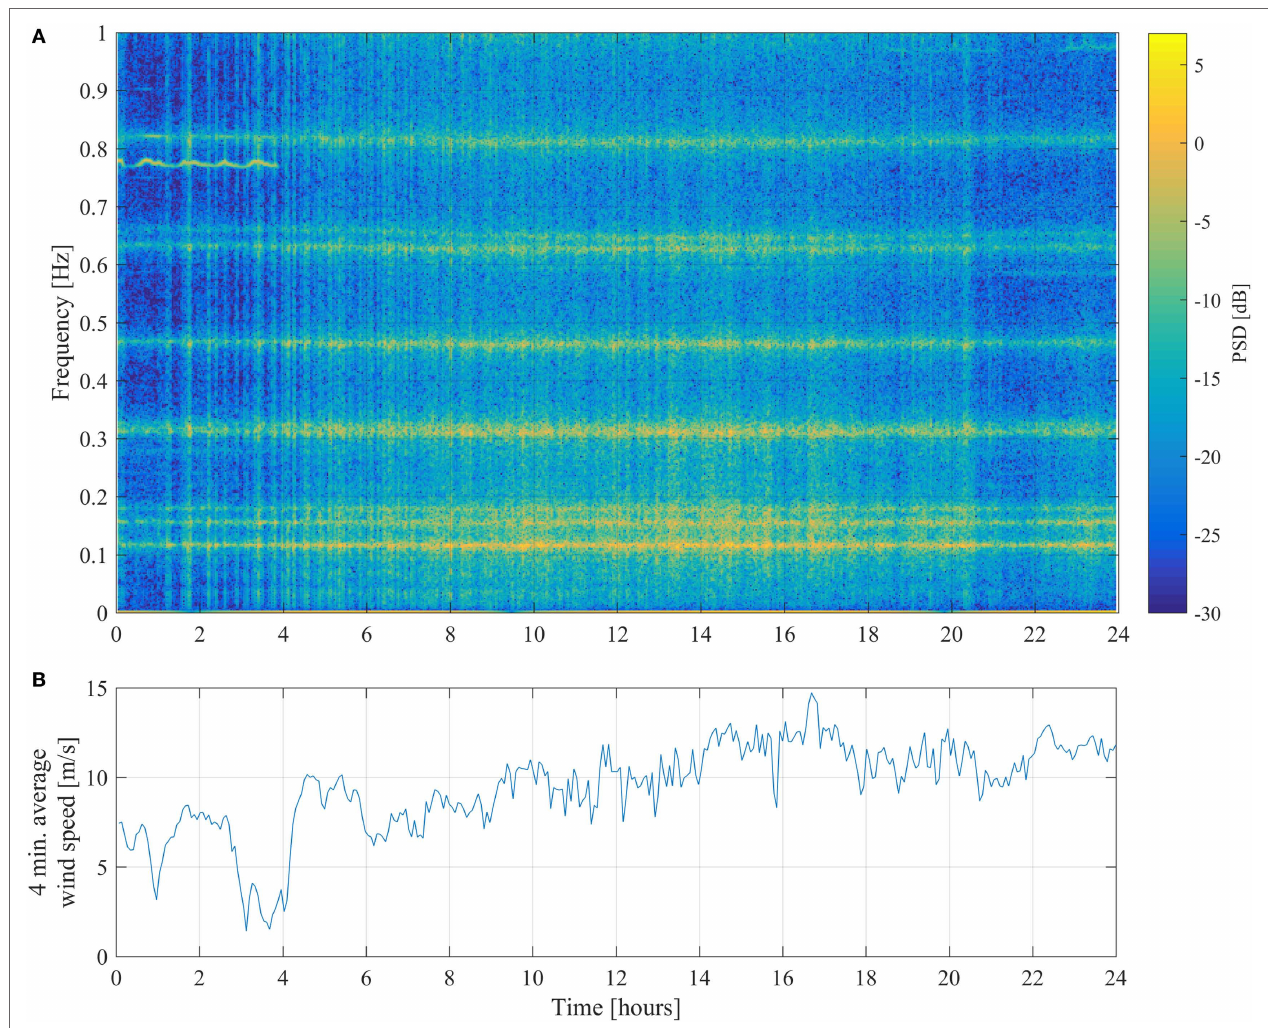
FIGURE 2 | Typical 1-day variation of the PSD of the acceleration response and the average wind speed: (A) PSD (spectrogram)– Hamming window, length 8,192 samples, overlap 5,792 samples ; (B) 2min average wind